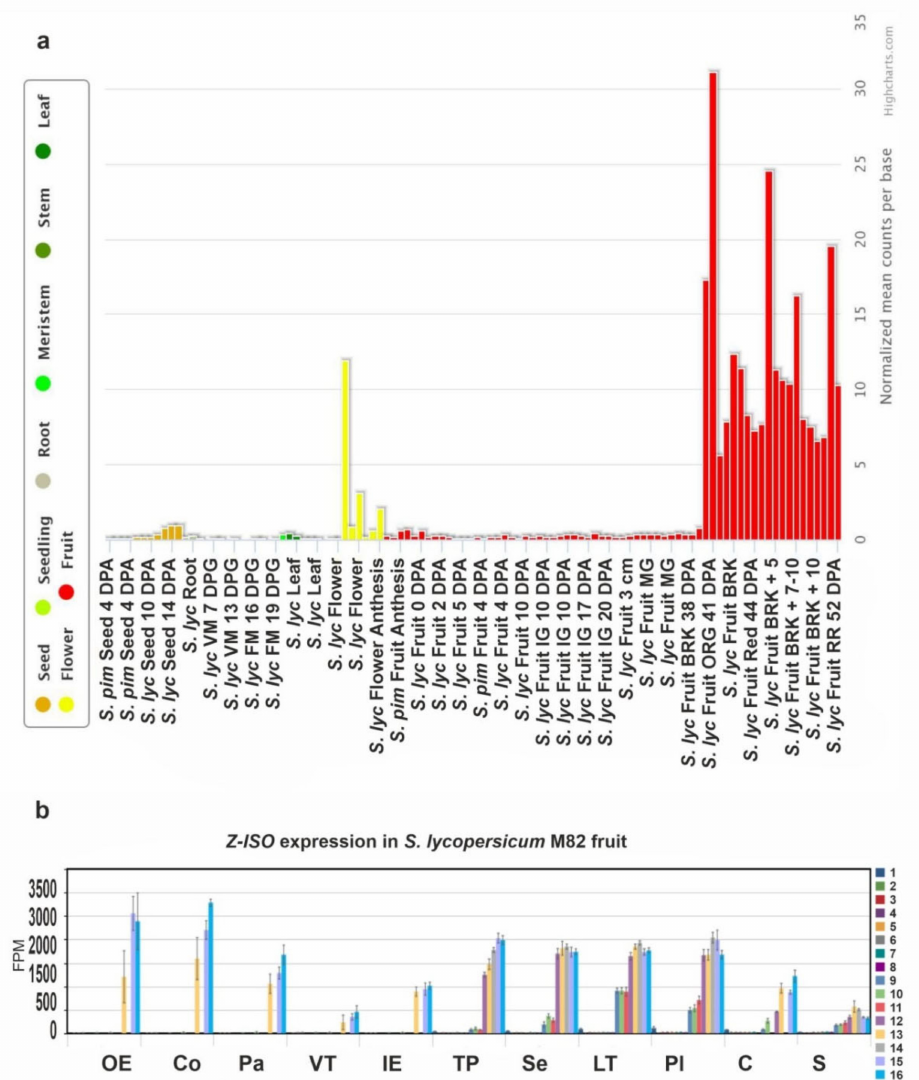
Figure 5. The Z-ISO expression pattern in tomato. ( a ) Diagram of Z-ISO mRNA expression in wild type S. lycopersicum ( S. lyc ) and S. pimpinellifolium ( S. pim ) (according to the TomExpress database, http://tomexpress.toulouse.inra.fr/, accessed on 10 August 2021). Gene transcription was ana- lyzed in roots, leaves, meristems (vegetative meristem, VM; floral meristem, FM), flowers, fruit (immature green, IG; mature green, MG; breaker, BRK; orange, ORG; red ripe, RR), and seeds. DPA, days postanthesis; DPG, days postgermination; the numbers after “+” indicate number of days. ( b ) Diagram of Z-ISO mRNA expression in different S. lycopersicum cv. M82 fruit tissues (OE—outer epidermis; Co—collenchyma; Pa—parenchyma; VT—vascular tissue; IE—inner epider- mis; TP—total pericarp; Se—septum; LT—locular tissue; Pl—placenta; C—columella; S—seeds) at 16 stages (1—anthesis; 2—5 DPA; 3—10 DPA; 4—20 DPA; 5—30 DPA; 6—MG stem; 7—MG equa- torial; 8—MG stylar; 9—BRK stem; 10—BRK equatorial; 11—BRK stylar; 12—Pink stem; 13—Pink equatorial; 14—Pink stylar; 15—Light Red; 16—Red Ripe) of growth and maturation (according to https://tea.solgenomics.net, accessed on 10 August